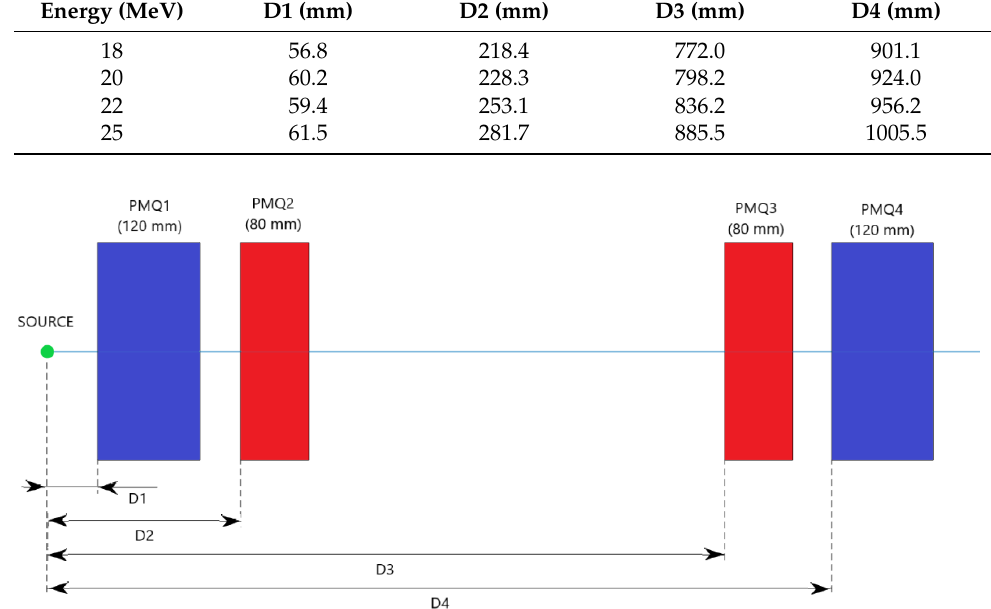
Table 2. Initial positions of the four PMQs for the configurations used to focus different energy beams. The distances are calculated with respect to the position of the source.